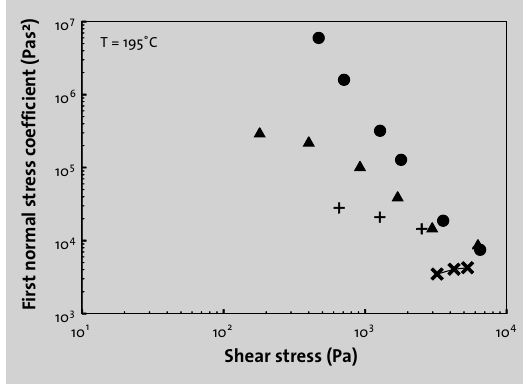
Figure 9 (left above): Variation of the talc1/LLDPE first normal stress coefficient versus shear stress at different volume fractions (X 0%, + 4%, Ú 8%, Ê 13%). Figure 10 (right above): First normal stress difference and coefficient as a function of shear rate. Figure 11 (right below): Relative zero-shear first normal stress coefficient at different volume